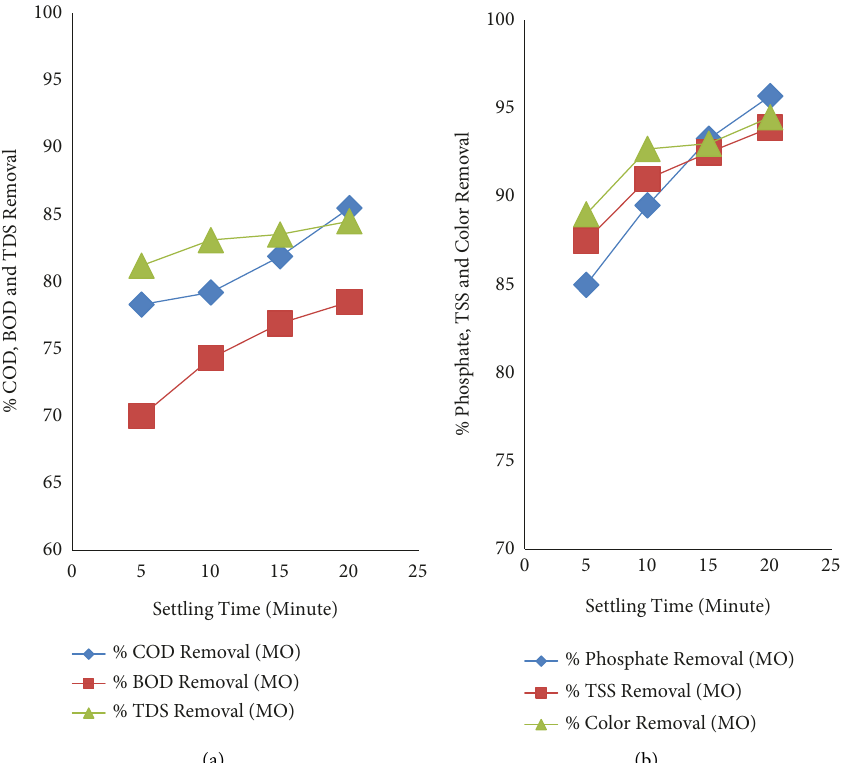
Figure 6: Effects of settling time on COD, BOD, and TDS removal efficiency (a) and phosphate, TSS, and color removal efficiency (b) using Moringa Oleifera